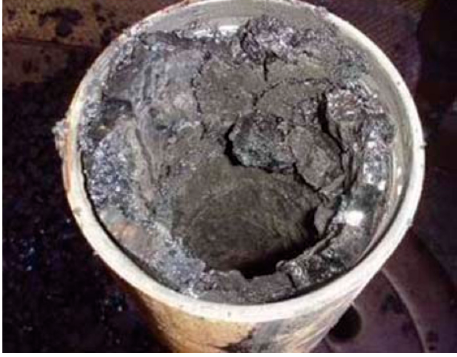
Figure 2. Clogging of a pipe by asphaltenes [6] .